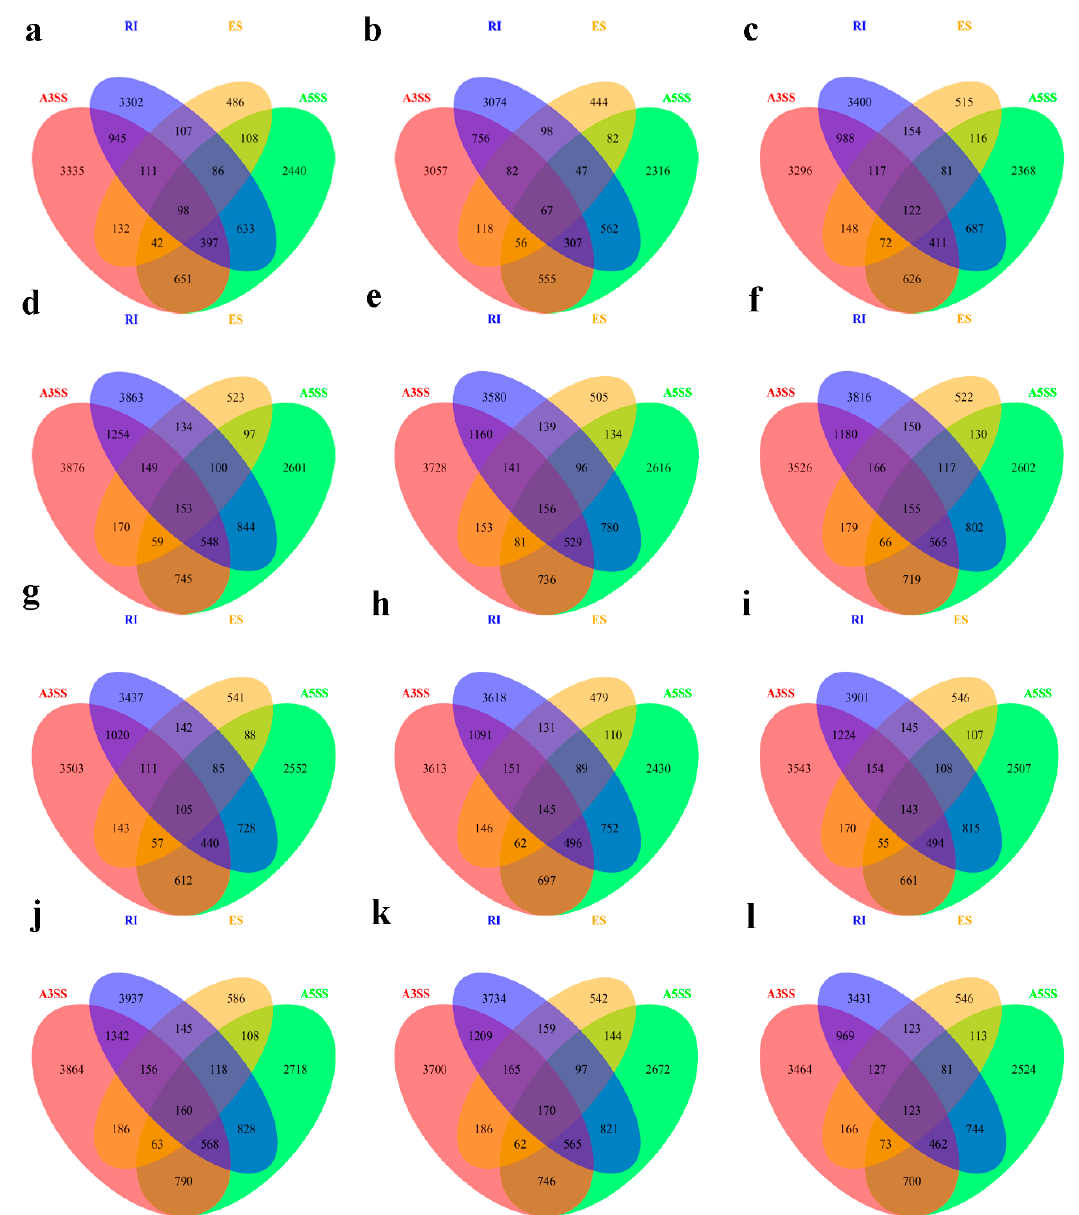
Figure 6. Venn diagram of the overlap of the four types of AS genes in B. napus cultivars Qingyou10 (QY10) and Westar10 (W10) under boron (B) sufficient and deficient conditions: ( a ) BsQR; ( b ) BsQJL; ( c ) BsQOL; ( d ) BdQR; ( e ) BdQJL; ( f ) BdQOL; ( g ) BsWR; ( h ) BsWJL; ( i ) BsWOL; ( j ) BdWR; ( k ) BdWJL; and ( l ) BdWOL. Q, QY10, Qingyou10; W, W10, Westar10; R, root; JL, juvenile leaves; OL, old leaves; Bs, B sufficient condition; Bd, B deficient condition.